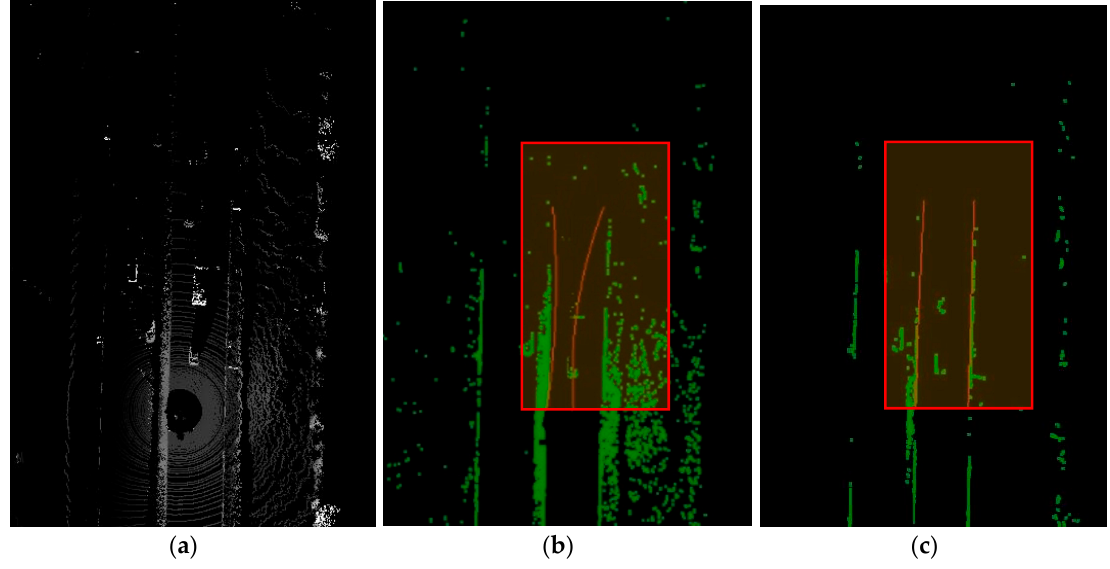
Figure 22. Comparison between the road detection result of [24] and this work. ( a ) Raw point cloud; ( b ) Result of [24]; ( c ) Result of this work.